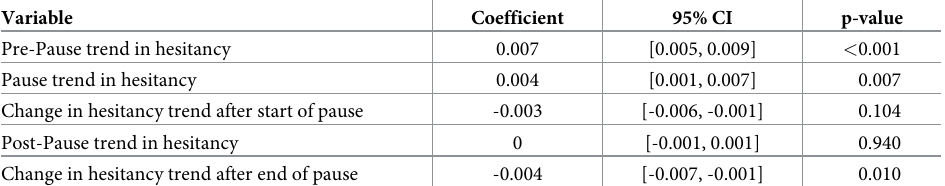
Table 2. Overall trend in COVID-19 vaccine hesitancy/refusal among unvaccinated individuals before, during and after J&J pause from segmented regression model [17,